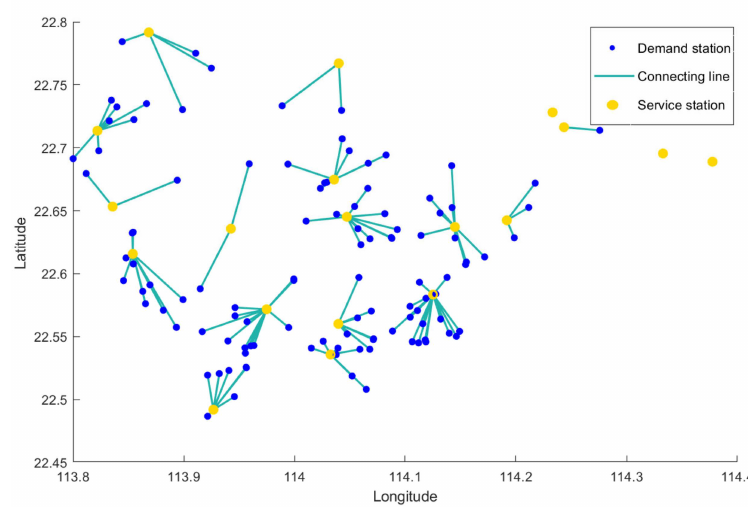
Figure 28. Locations of the charging